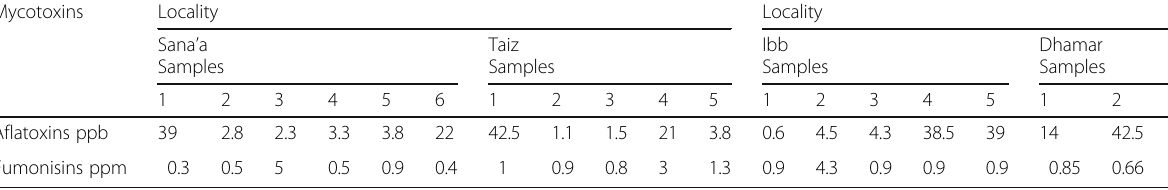
Table 5 Mean level of aflatoxins and fumonisins in poultry ration samples collected from farmer ’ s poultry farms Mycotoxins Locality